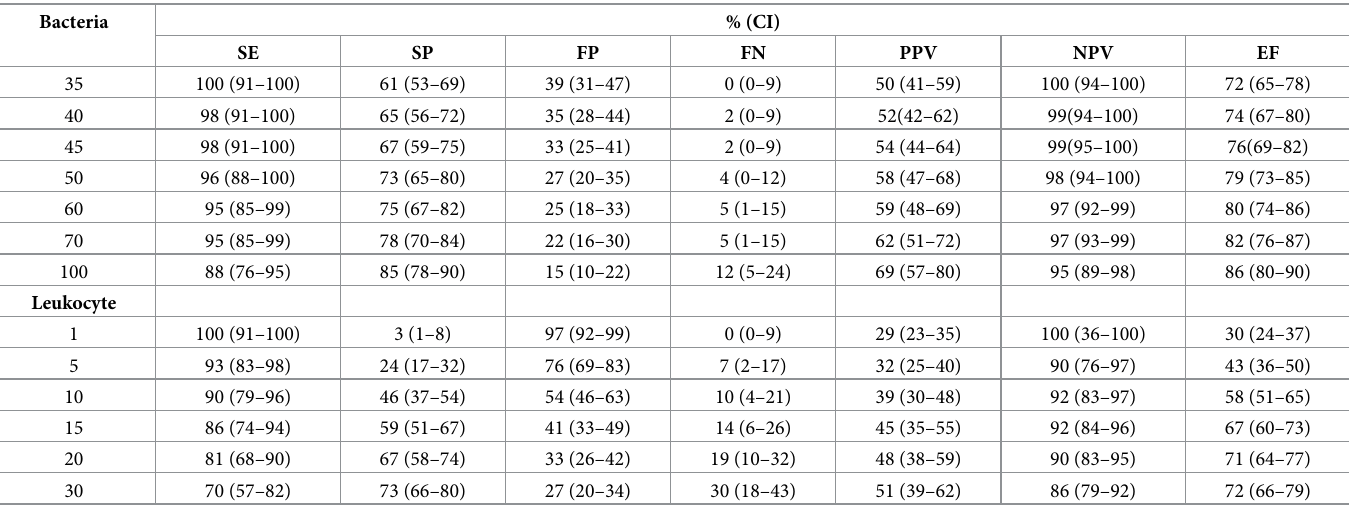
Table 1. Bacteria and leukocyte count in urine specimens from neonates.